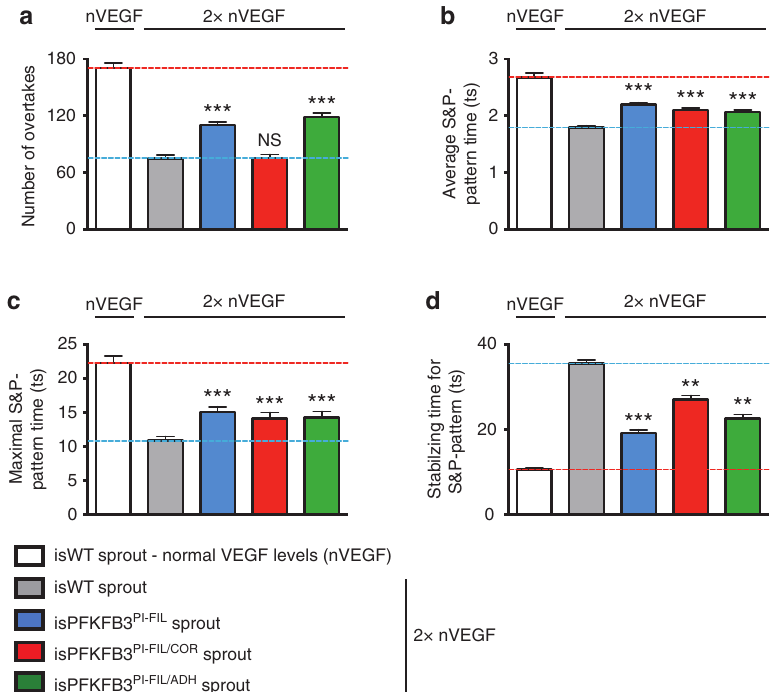
Figure 5 | Modifying E FIL and E FIL/ADH partially normalizes EC dynamics. ( a–d ) Number of overtakes ( a ), the average ( b ) and maximal time ( c ) during which a salt and pepper (S&P) pattern is maintained, and the time required to acquire a stable S&P pattern ( d ) for in silico WT (isWT) ECs in non-mosaic sprouts, in which PFKFB3 was pharmacologically blocked (isPFKFB3 PI ) simulated by modifying E FIL (blue), E FIL/COR (red) and E FIL/ADH (green) in VEGF levels 2-fold higher than normal (2 (cid:2) nVEGF). The white and grey bars represent a simulated isWTsprout in normal VEGF (nVEGF) and 2 (cid:2) nVEGF levels, respectively. The horizontal red and blue dotted lines show the particular values of an isWT sprout in normal and 2 (cid:2) VEGF levels, respectively. ts: timestep. Data are mean ± s.e.m.; n ¼ 50; NS, not significant, ** P o 0.01, *** P o 0.001 versus isWT in 2 (cid:2) nVEGF; Student’s t